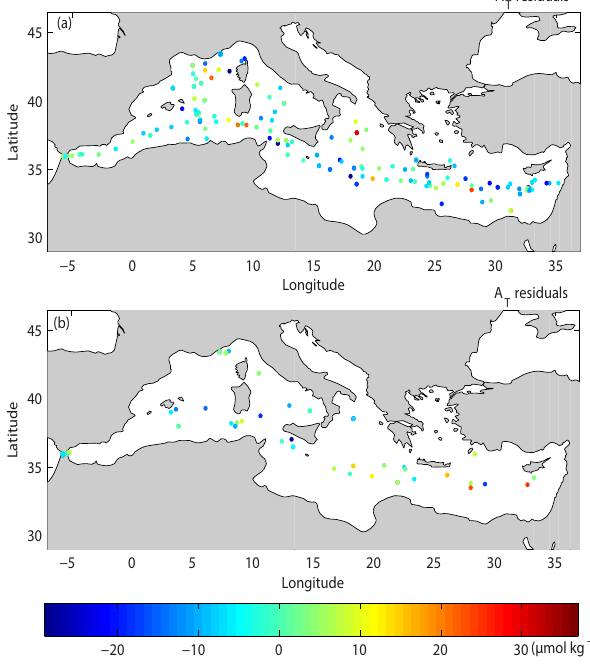
Figure 2. Map of the residuals of the A T algorithm (Eq. 1) applied to the (a) training and (b) testing data